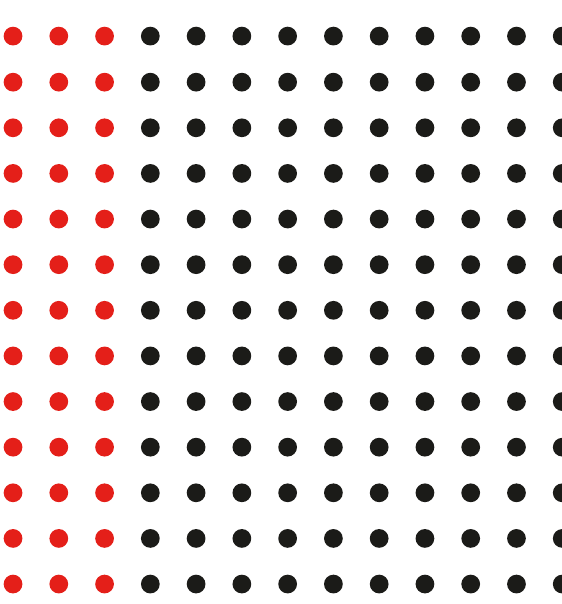
Figure 19: Schematic diagram of uplifted nodes under H case: 39 nodes uplifted and uplift area ratio is